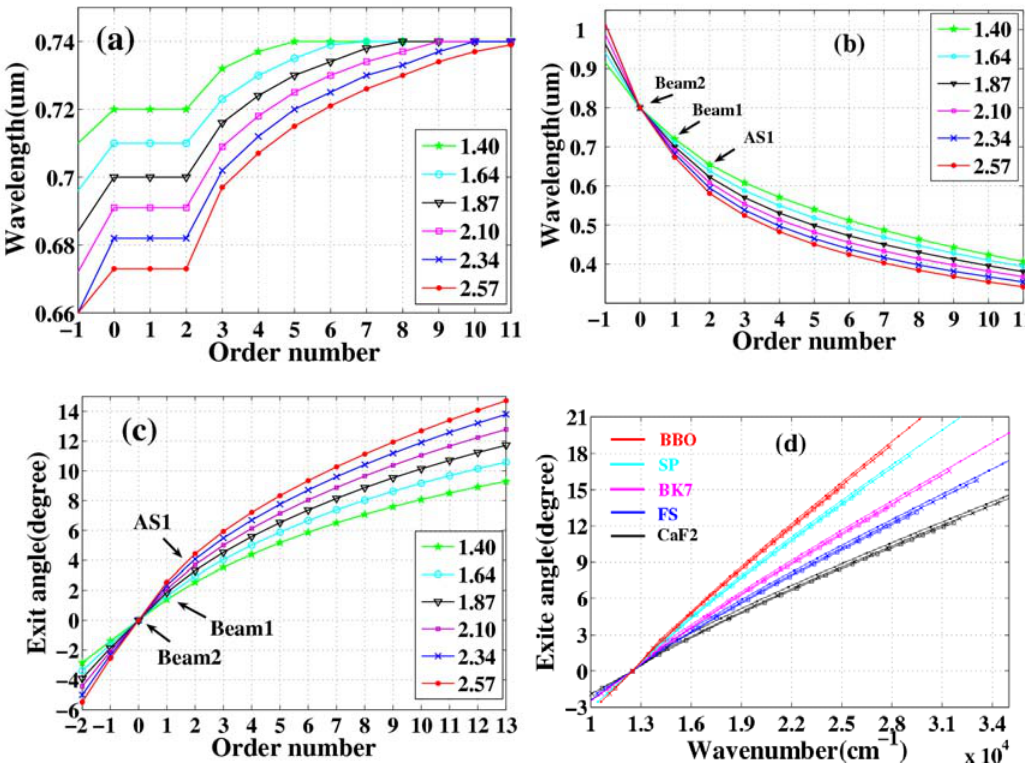
Figure 36. Order number dependence of (a) the wavelength of generated sidebands, (b) the wavelength of beam 1 for optimal phase matching, and (c) the exit angles of the generated sidebands obtained at six different crossing angles (1.40º, 1.64º, 1.87º, 2.10º, 2.34º, and 2.57º) in a 1-mm-thick fused silica plate. (d) The dependence of the exit angle of the generated sidebands on the center wavelength of generated sidebands at 1.40º, 1.87º, and 2.57º three different crossing angles in five different media (CaF sapphire plate, and BBO crystal)